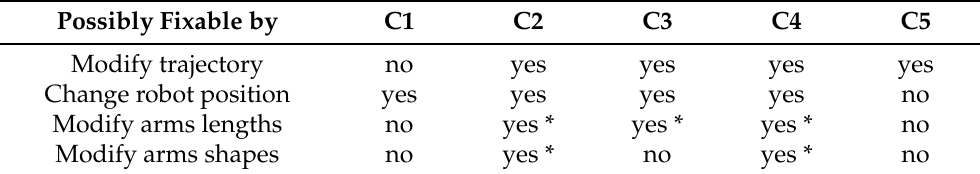
Table 2. Overview of five categories of collisions with possible ways of removing them; only cases marked by an asterisk (*) are considered in this